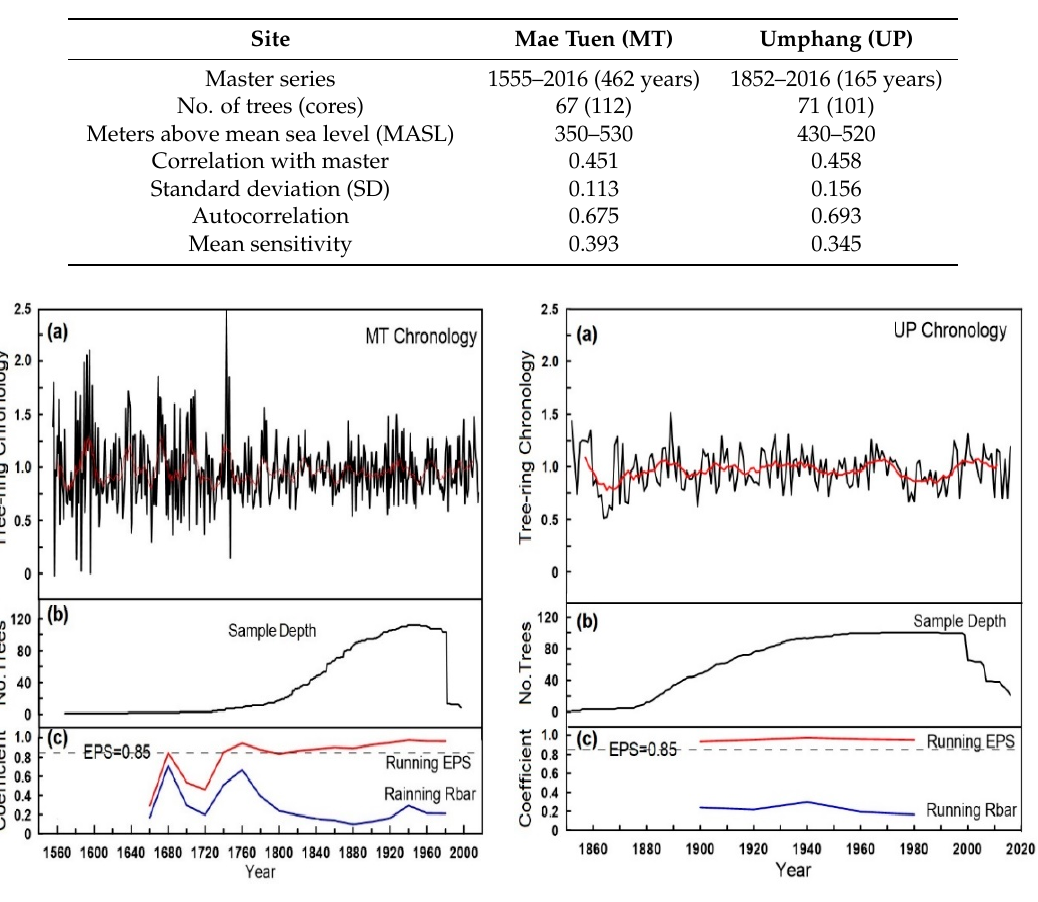
Table 3. Statistics of tree-ring chronologies from two different sites in Tak province.